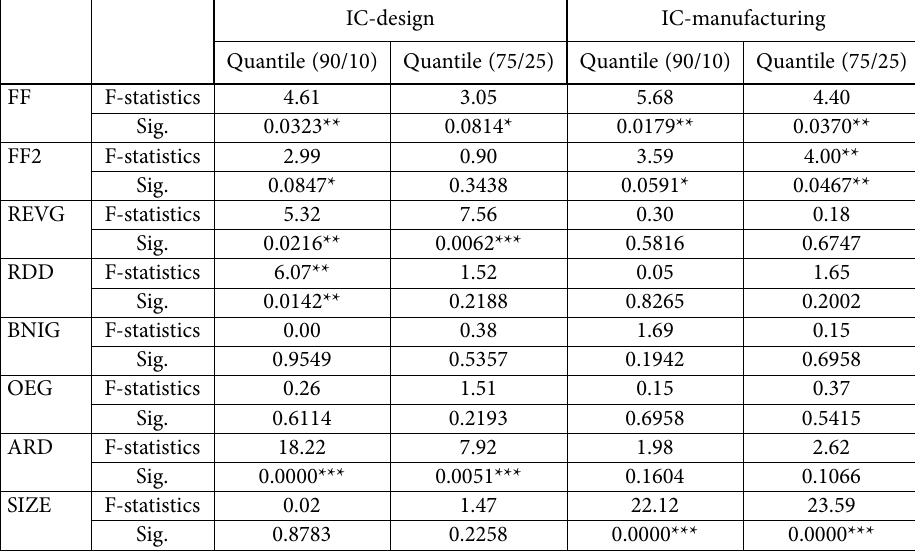
Table 7. Inter-quantile regression results for FF: IC-design and